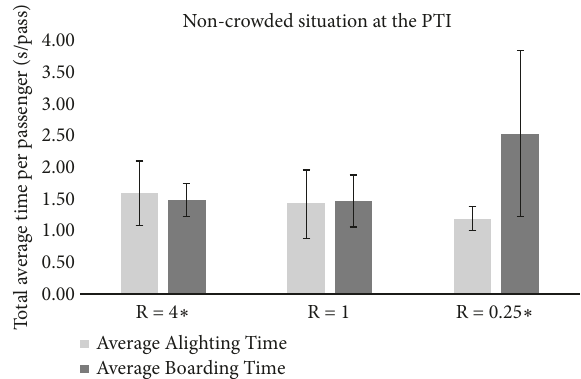
Figure 4: Total average boarding time per passenger ( 𝑡 𝑏𝑛 ) and total averagealighting time per passenger ( 𝑡 𝑎𝑚 ) in noncrowded situations at the